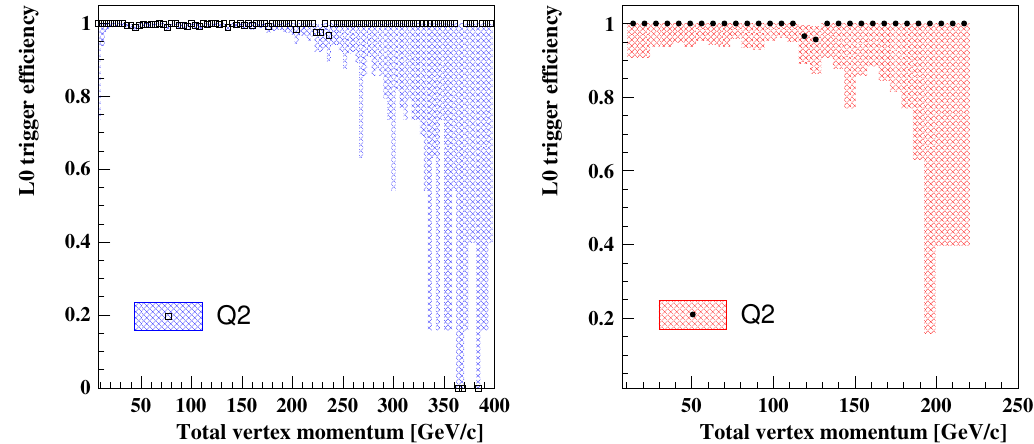
Figure 10. Efficiency of the Q2 trigger condition in beam-dump data, measured as a function of the total vertex momentum using events collected via the control trigger (left) or the neutral trigger (right) lines reported in table. 3. The hatched areas indicate the statistical uncertainties of the